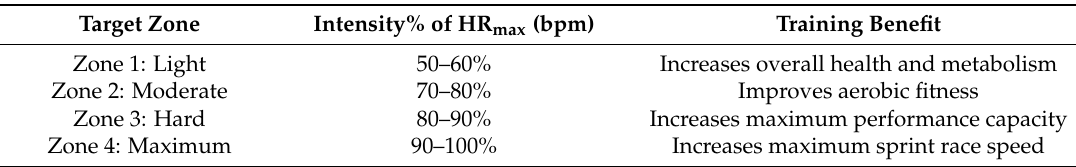
Table 1. Heart Rate training zones.